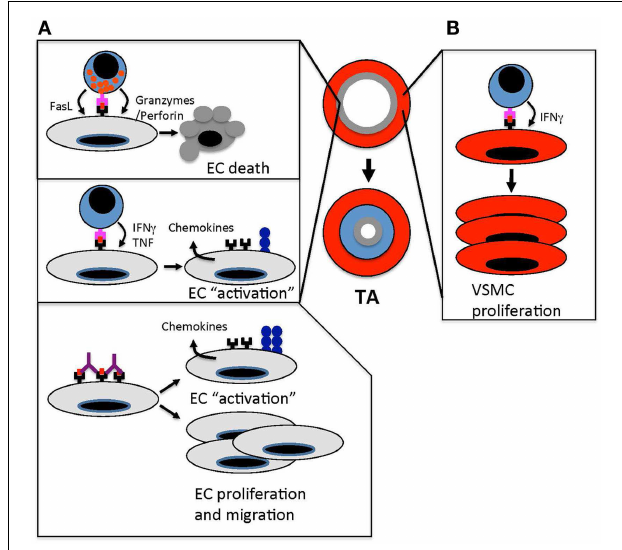
FIGURE 1 | Immune-mediated vascular changes that causeTA . (A) . EffectorT cells target ECs in arteries of transplanted organs. Cytotoxic T cells kill arterial ECs through granzyme/perforin- and FasL-mediated pathways.This endothelial damage triggers a “response-to-injury” process that involves leukocyte and smooth muscle cell migration into the arterial intima that drives intimal thickening and occludes the arterial lumen. In addition to cytotoxicT cell responses,T cell recognition of allogeneic ECs results in the secretion of effector cytokines, such as IFN γ andTNF, which “activates” the endothelium to up-regulate MHC class I and II, cell adhesion molecules, and chemokines.These changes amplify the recruitment of leukocytes into allograft arteries. Anti-MHC antibodies amplify immune responses in allograft arteries by cross-linking MHC molecules, which induces cell signaling pathways that up-regulate adhesion molecules and vonWillebrand factor.This enhances leukocyte transendothelial migration. Anti-MHC antibodies also induce proliferation and migration of ECs, which could trigger the remodeling of allograft arteries. (B) The secretion of IFN γ from effectorT cells stimulates the proliferation of vascular smooth muscle cells in the intima of allograft arteries.This increases the accumulation of vascular smooth muscle cells and intimal